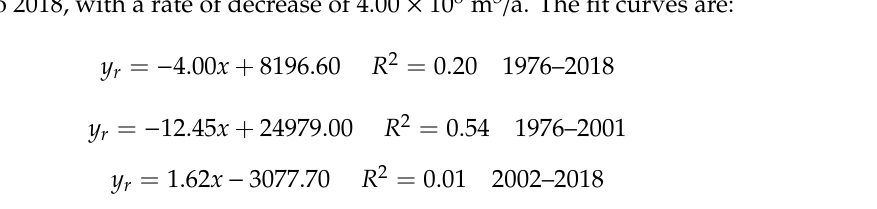
Figure 6. Variations in annual runo ff ( a ) and sediment discharge ( b ) at the Lijin station during 1976– 2018.